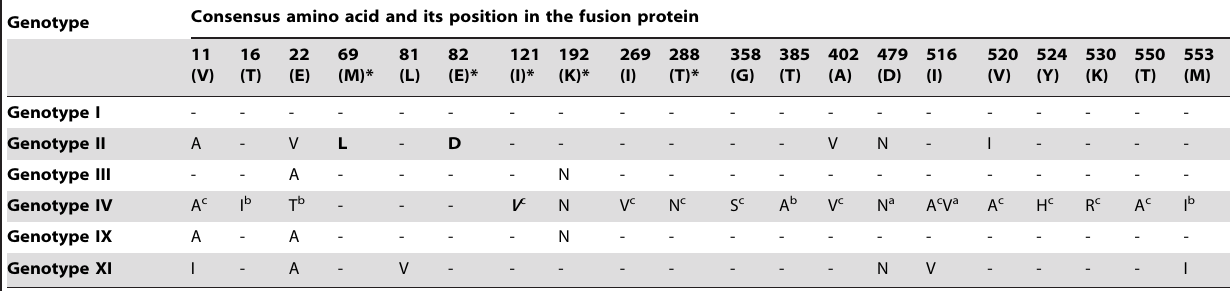
*Genotype specific residue positions already reported ( Yu et al., 2001 ). a Residues at the indicated positions in classical genotype IV strains – Italian (EU293914) and Herts’33 (Ay741404). b Residues at the indicated positions only in both the Indian and the classical genotype IV strains. c Residues at the indicated positions found in genotype IV strains from India - NDV-2K3 (FJ986192) and NDV2 (GU187941) and not in the classical genotype IV virus. N Eventhough the genotype XI strains groups in the same clade along with genotype IV there were several residues positions that were unique. N Substitutions L69M and D82E reported for evolution of the genotype II (bold faced). N Theresiduesubstitutions(VtoA, A to V & D toN respectively)at positions 11,402& 479respectivelyin Indiangenotype IV strainsarealsoobservedingenotypeII strains. N Substitution V121I reported for the evolution of VIIb (bold